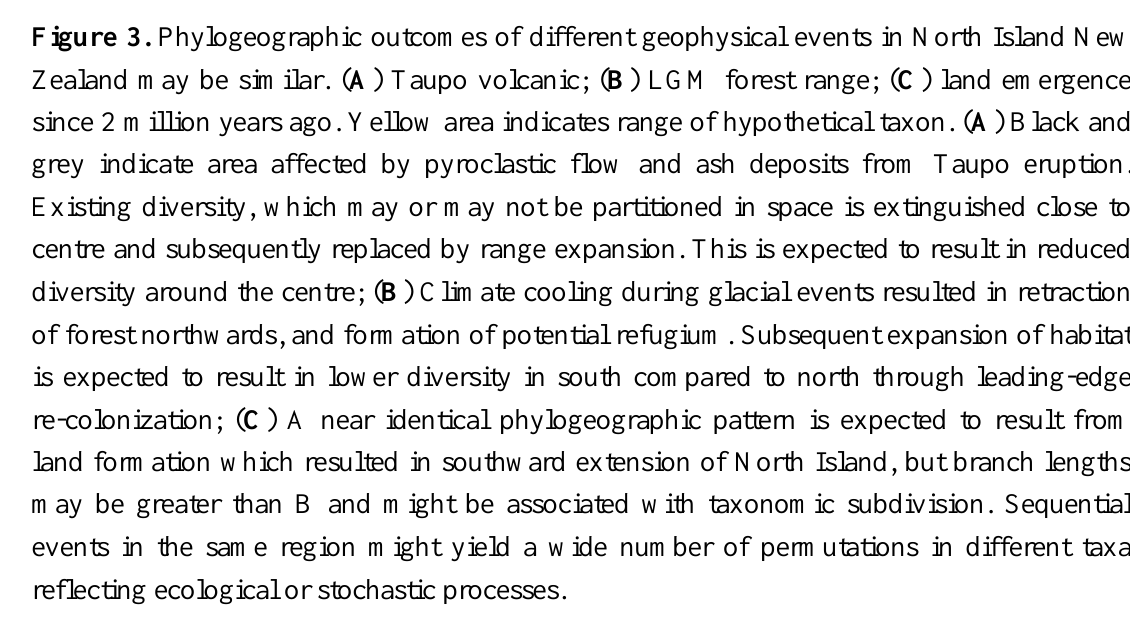
Figure 3. Phylogeographic outcomes of different geophysical events in North Island New Zealand may be similar. ( A ) Taupo volcanic; ( B ) LGM forest range; ( C ) land emergence since 2 million years ago. Yellow area indicates range of hypothetical taxon. ( A ) Black and grey indicate area affected by pyroclastic flow and ash deposits from Taupo